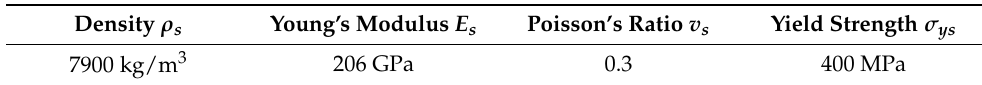
Table 5. Properties of steel